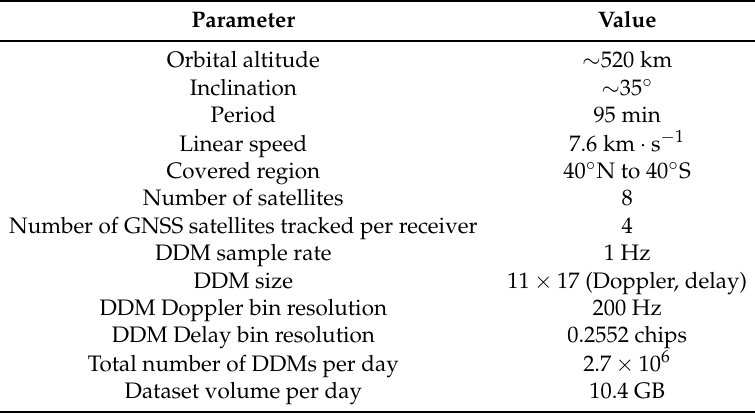
Table 1. Summary of CYGNSS mission.